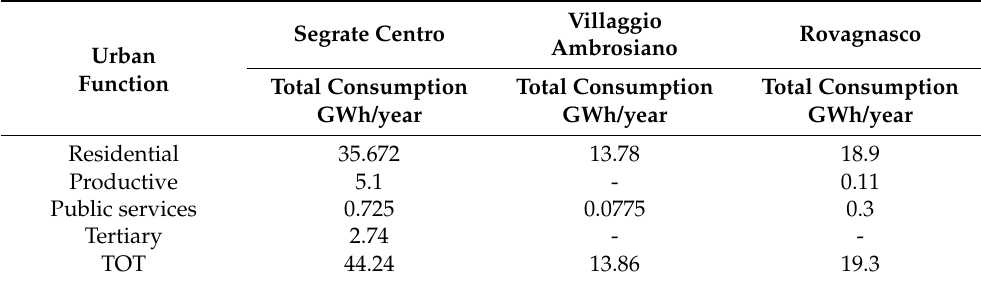
Table 6. Final energy consumption in each urban function in the case study’s neighborhoods consid- ering the use of PV and low-temperature geothermal